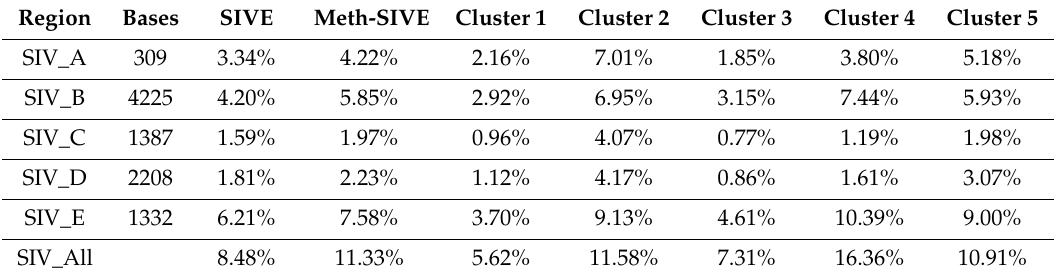
Figure 4. ( A ) Schematic representation of SIV genome and its annotations. ( B ) Characterization of SIV transcripts based on major splicing patterns. This figure was created based on a modification of those found in [55,60]. Table 2. Distribution of SIV transcripts by region in cells classified by condition or cluster.